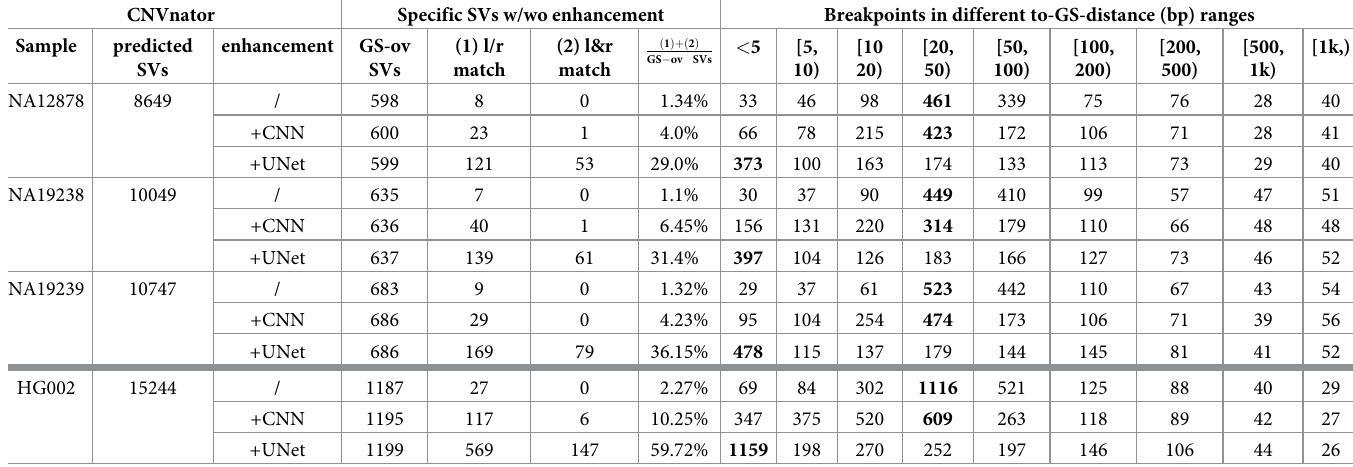
Table 4. In-sample enhancement for the CNVnator using 50 bp bin size. For each SV caller, the largest number of breakpoints in the split regions is highlighted in bold. “GS-ov” SVs are referred to as gold-standard overlapping SVs. “l/r match” represents SVs with partial-boundary-match (left or right). “l&r match” denotes SVs with both- boundary-match (left and